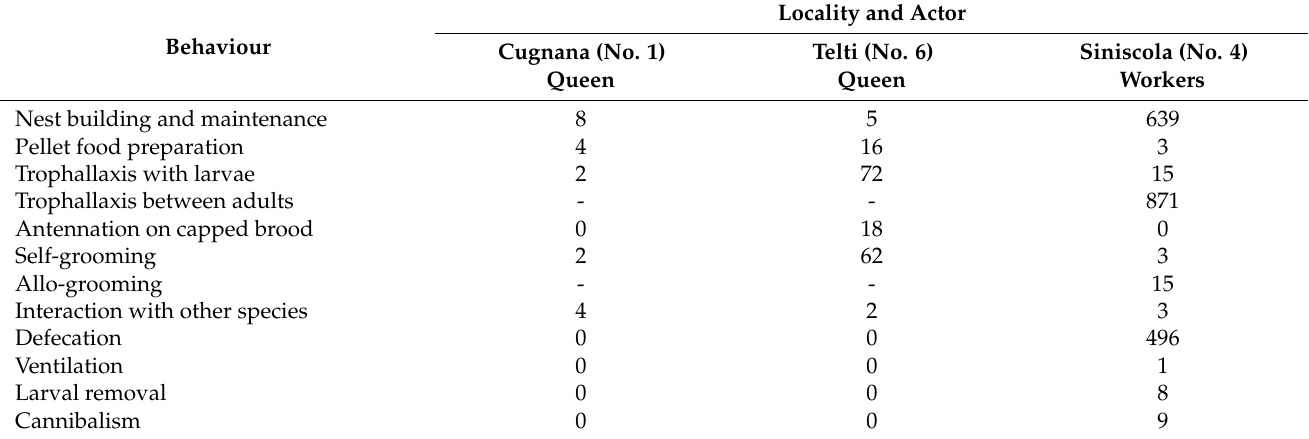
Table 2. Number of events of intranidal tasks performed by queens and workers of Vespa crabro in north-eastern Sardinia (Italy). Data are relative to the activity of the queen observed for 7 h in the Cugnana and Telti nests, and the activity of the workers for a total of 28:10 (hours:min) in the Siniscola